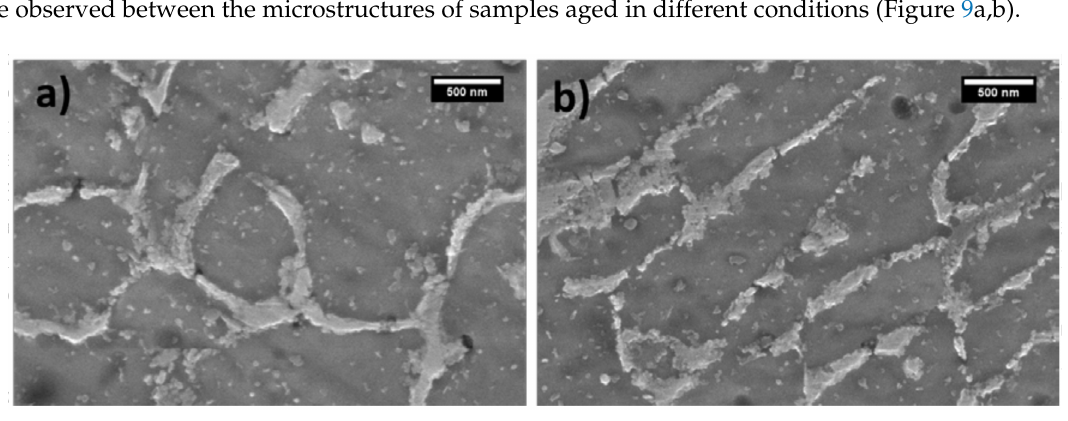
Figure 9. FE-SEM micrographs of 50% 7075 built with the optimized parameters aged for ( a ) 3 h at 170 ◦ C and ( b ) for 6 h at 160 ◦